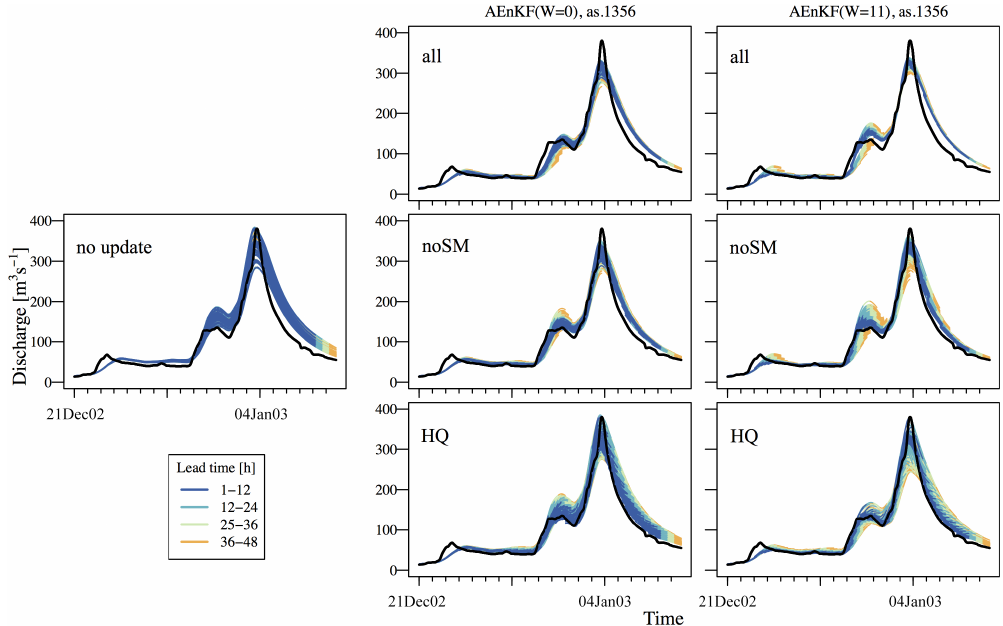
Figure 6. Ensemble of discharge forecasts for a typical event at the catchment outlet (Tabreux, gauge 1) for three updating scenarios: all, noSM, and HQ (see Table 2 for definition). The combined effect of the model states being updated (three scenarios shown in rows) and the length of the state augmentation vector ( W ) of past observations being assimilated (two scenarios in columns) is presented. Gauges 1, 3, 5, and 6 are assimilated. The control run (with no update) is shown in the left panel. The observations are shown in